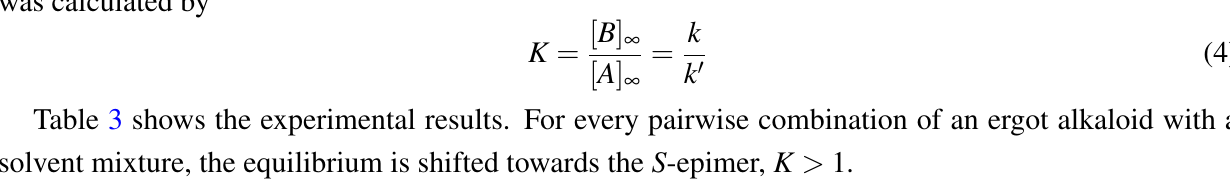
Table 3. Kinetic parameters for α -ergocryptine and ergocornine in solvent mixtures i, ii. Solvent